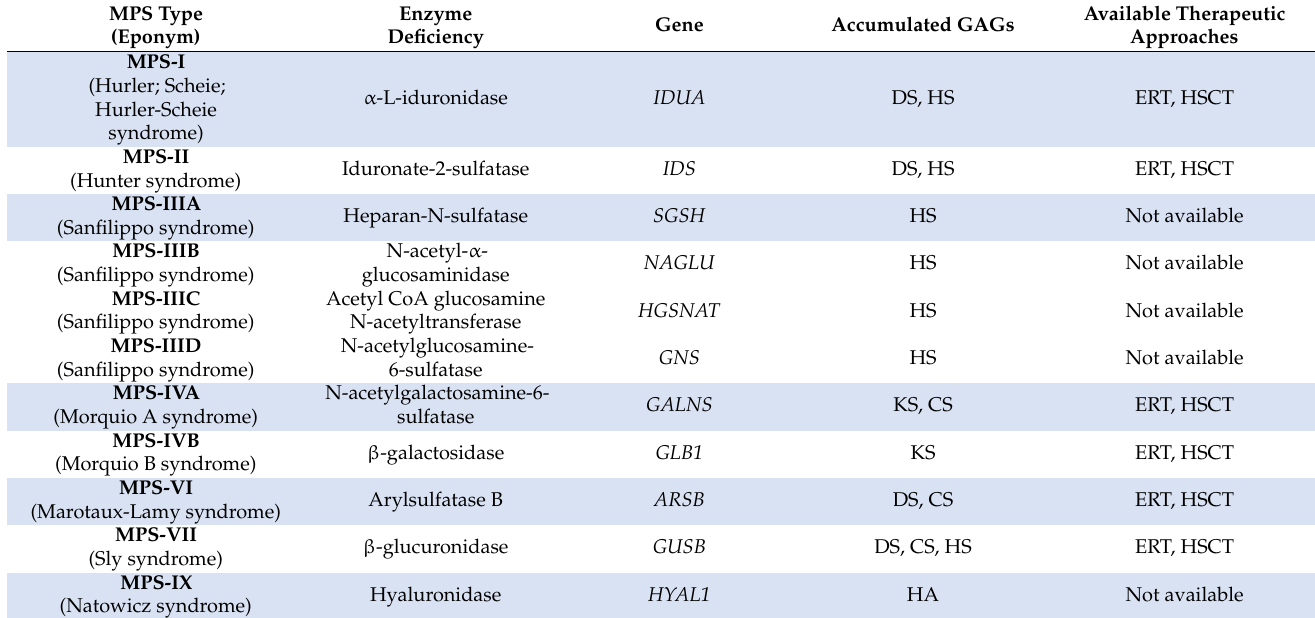
Table 1. General characteristics of